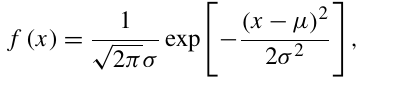
Figure 1. Framework of 3D indoor positioning system.